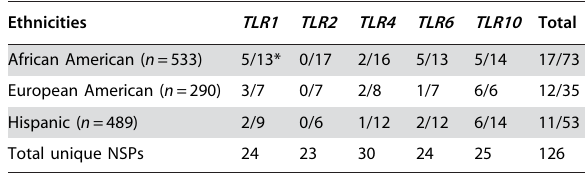
Table 1. Distribution of common and rare